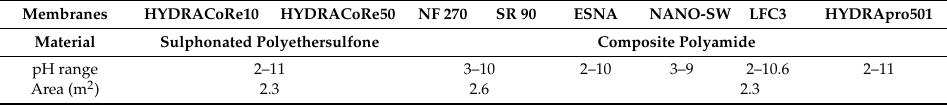
Table 2. Membrane characteristics as provided by the suppliers.